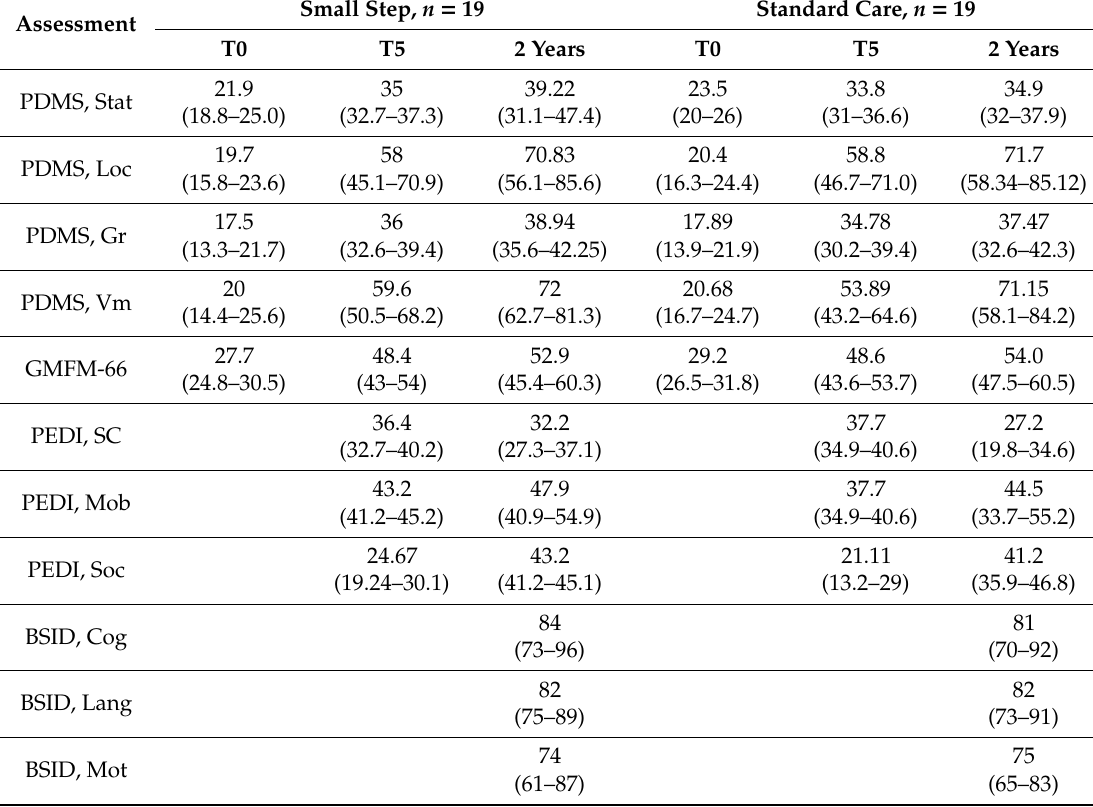
Table 2. Means and 95% confidence intervals for the Peabody Developmental Motor Scales 2ed (PDMS, raw score), Gross Motor Function Measure-66 (GMFM-66), Pediatric Evaluation of the Disability Inventory (PEDI, functional scale, scaled score), and Bayley Scales of Infant Development III (BSID, index